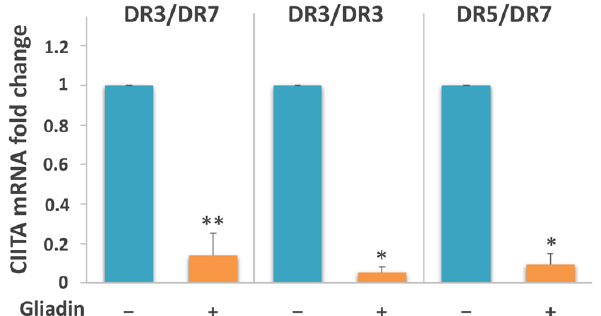
Figure 8. Analysis of expression of CIITA mRNA. CIITA mRNA decreased 7-fold in M Φ carrying the DR3/DR7 genotype ( n = 4: CD20, CD25, CD31, and CD35), 20-fold in samples with the DR3/DR3 genotype ( n = 2: CD14 and CD18) and 11-fold in M Φ carrying the DR5/DR7 genotype ( n = 2: CD26 and CD34) after overnight gliadin stimulation (* p < 0.05, ** p < 0.01).